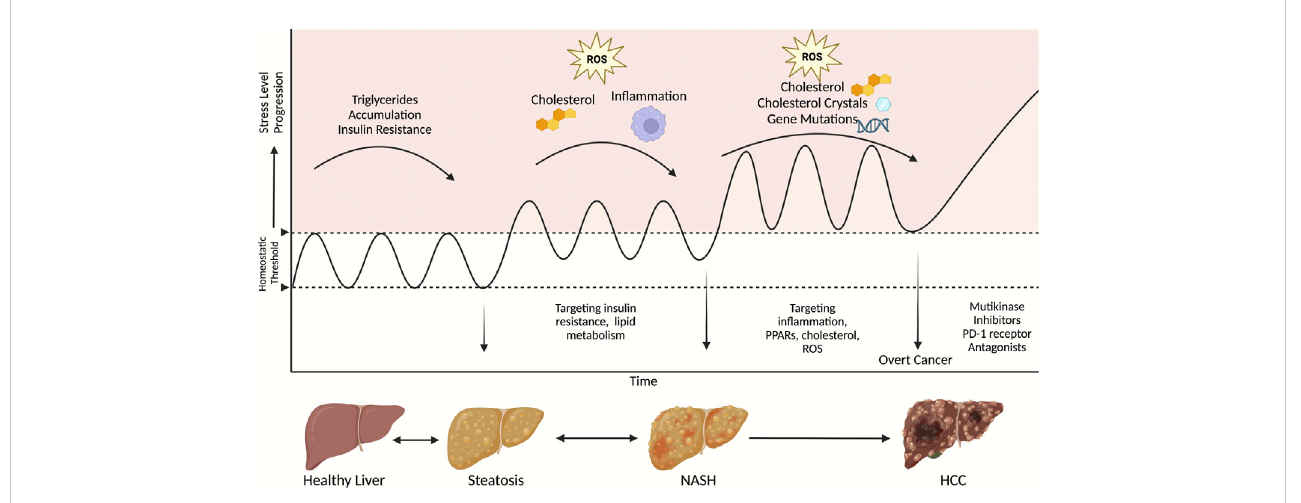
FIGURE 1 A schematic of therapeutic strategies to target NASH and HCC at different stages of disease progression. This fi gure was created with